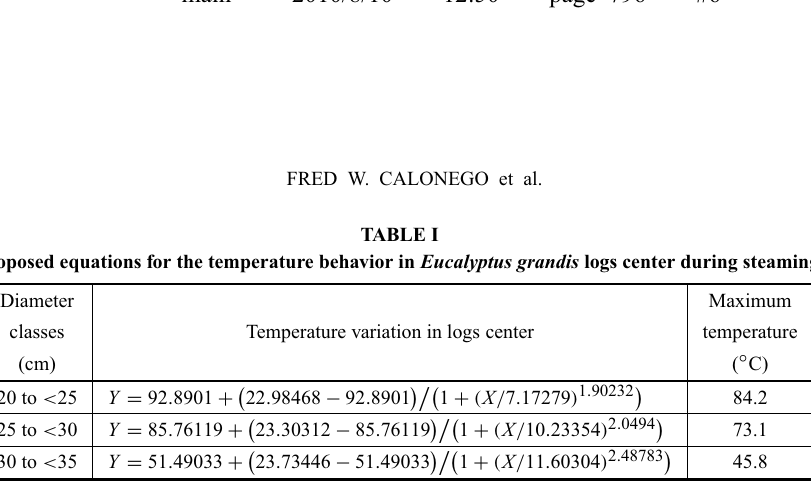
End-cracks average length variation in center and peripheral boards after sawing steamed logs of Eucalyptus grandis . Logs 30 at < 35 Logs 25 at < 30 Logs 20 at < 25